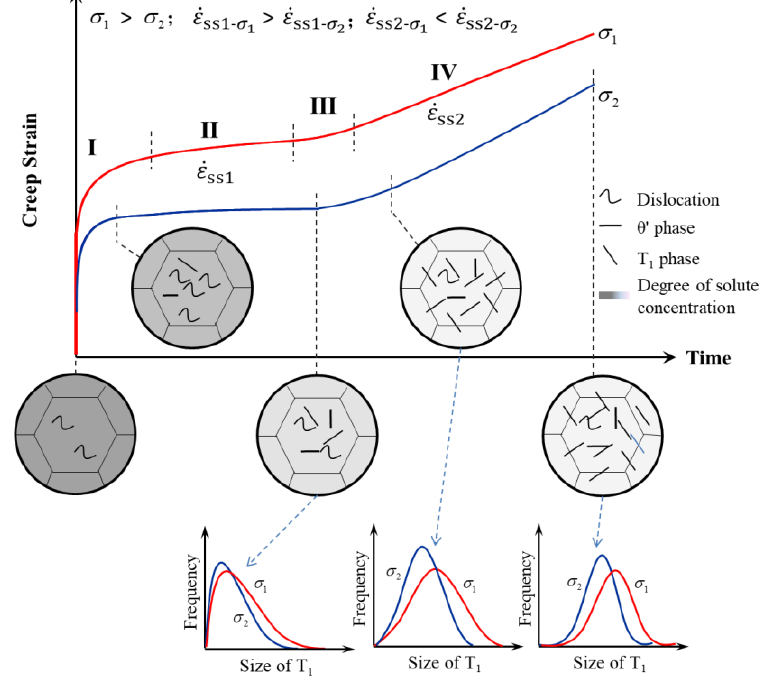
Figure 9. Schematic diagrams of creep dominant factors at di ff erent stages in the “multi-step” creep curve of Al-Li-S4 aluminum alloy.